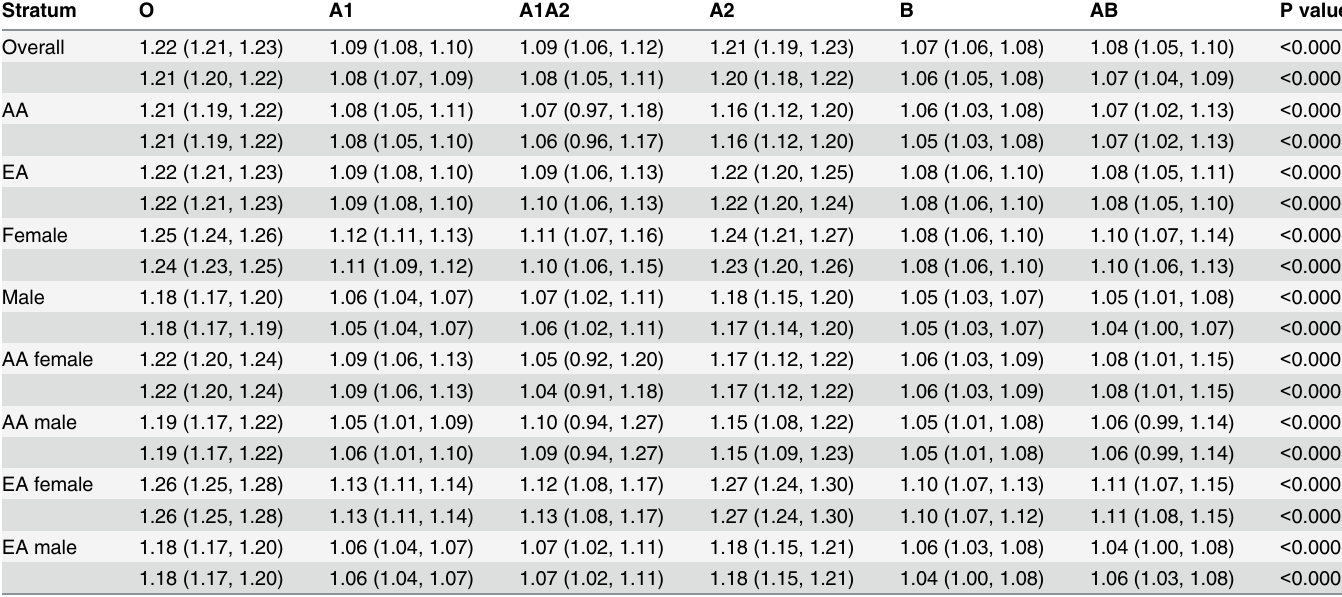
Top row: unadjusted values; bottom row (shaded): values adjusted for age, smoking, BMI, diabetes, and hypertension (race and gender were also included for overall population; race in the gender-speci fi c analyses and gender in the race-speci fi c analyses)